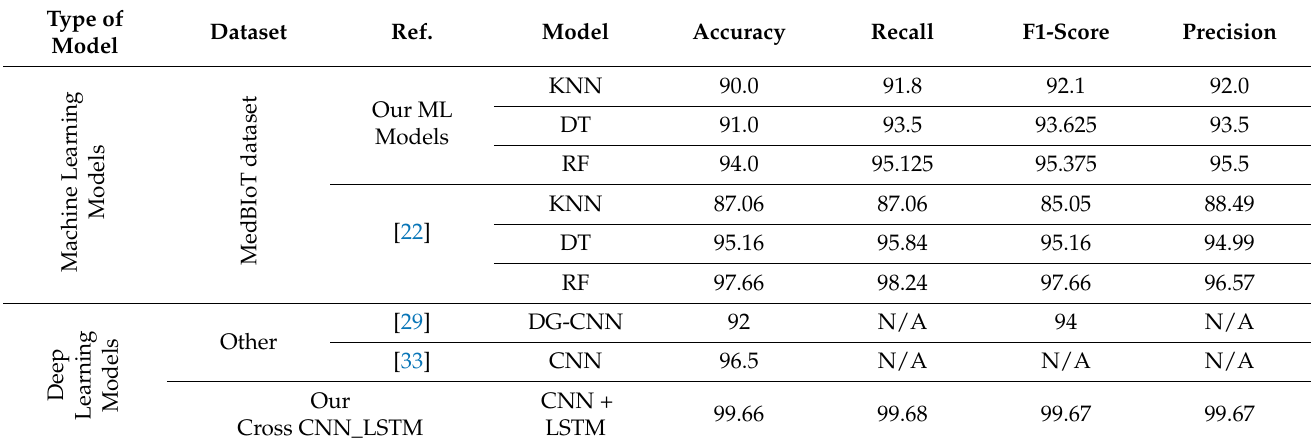
Table 12. Results of the conducted comparisons (N/A = not available).